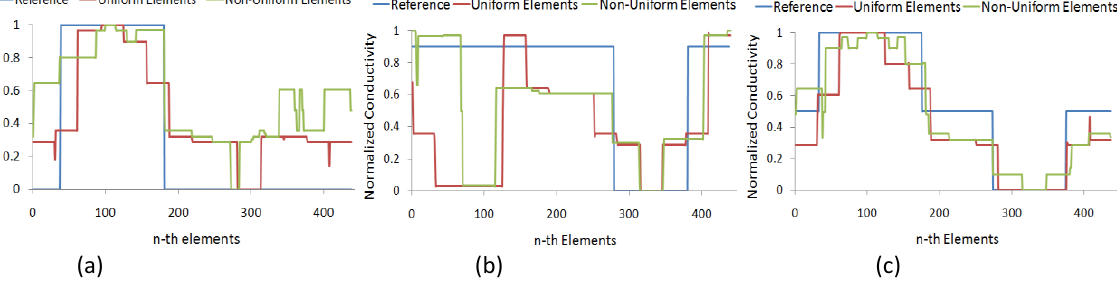
Figure 15: Line profile of reconstruction images from the Newton-Raphson methods of uniform and non-uniform elements compared to reference. (a) Insulator object, (b) conductor object, and (c) insulator-conductor object